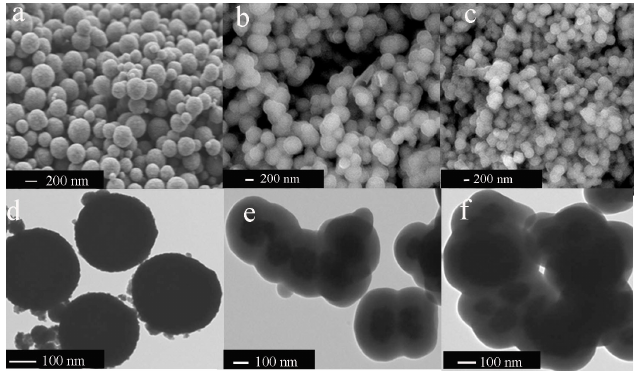
Figure 2. Scanning electronic microscope (SEM) images of Fe 3 O 4 ( a ); Fe 3 O 4 @SiO 2 ( b ); Fe 3 O 4 @SiO 2 @GdVO 4 :Dy 3+ ( c ); and transmission electron microscopy (TEM) images of Fe 3 O 4 ( d );